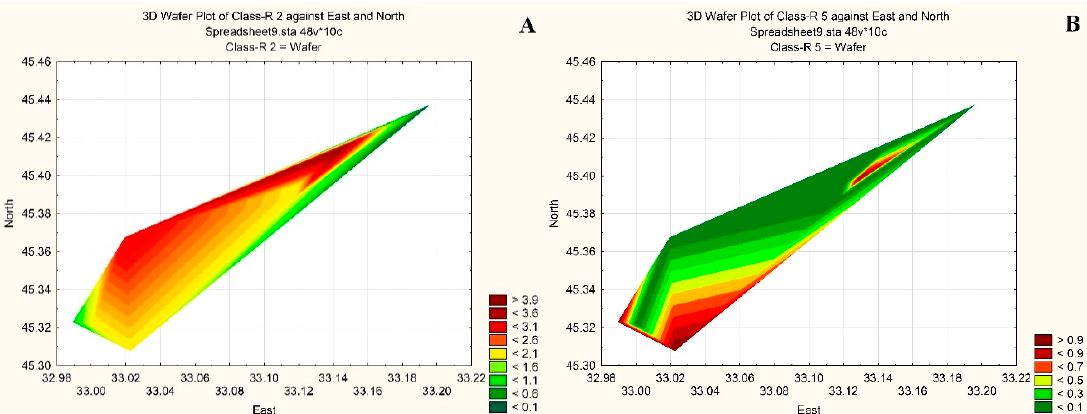
Figure 5. Maps of saprobity indicators of class 2 ( A ) and 5 ( B ) of water quality in the Donuzlav Gulf of the Black Sea (2018–2019). Table 2. The hydrochemical parameters of Donuzlav Gulf waters of the Black Sea. № st.